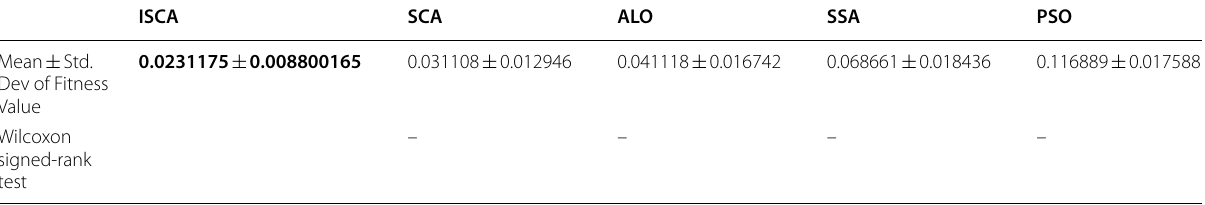
Table 5 Comparison of fitness values and WRST results of the three-area system with SLD of 2% in area-1 and area-2 using Different Optimization Techniques (Values in bold show best value)